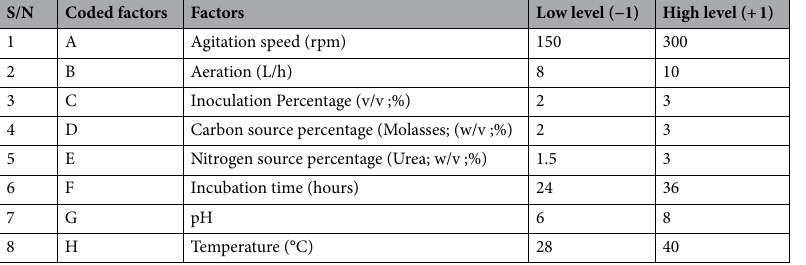
Table 6. High and low levels of factors used in